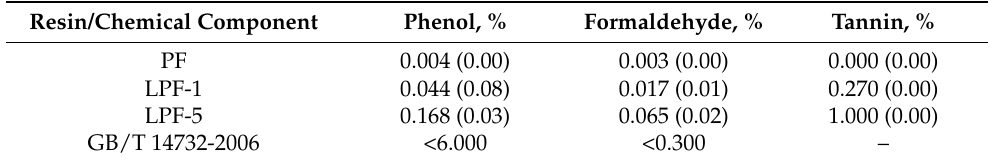
Table 2. Chemical analysis of resins.